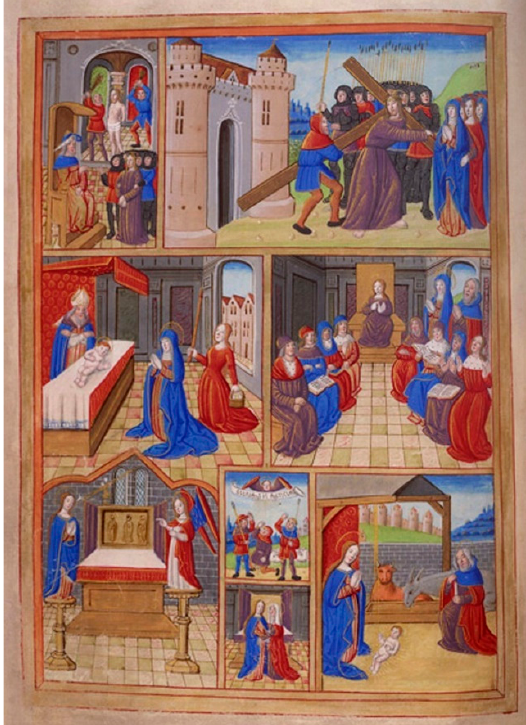
Figure 8. Pictorial cycle f.54v of the Hours of Thomas Butler, © British Library Board.